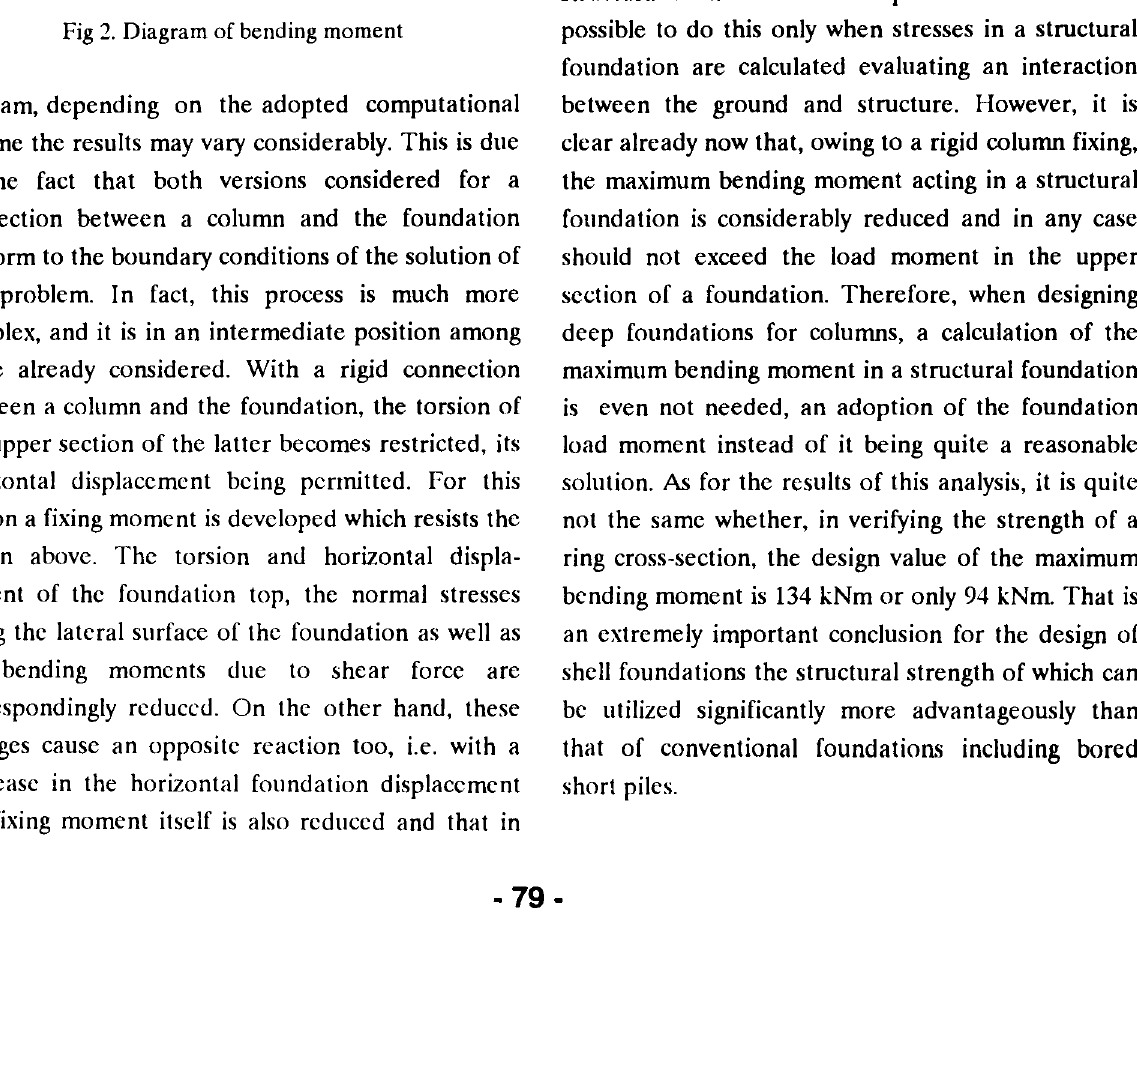
Fig 2. Diagram of bending